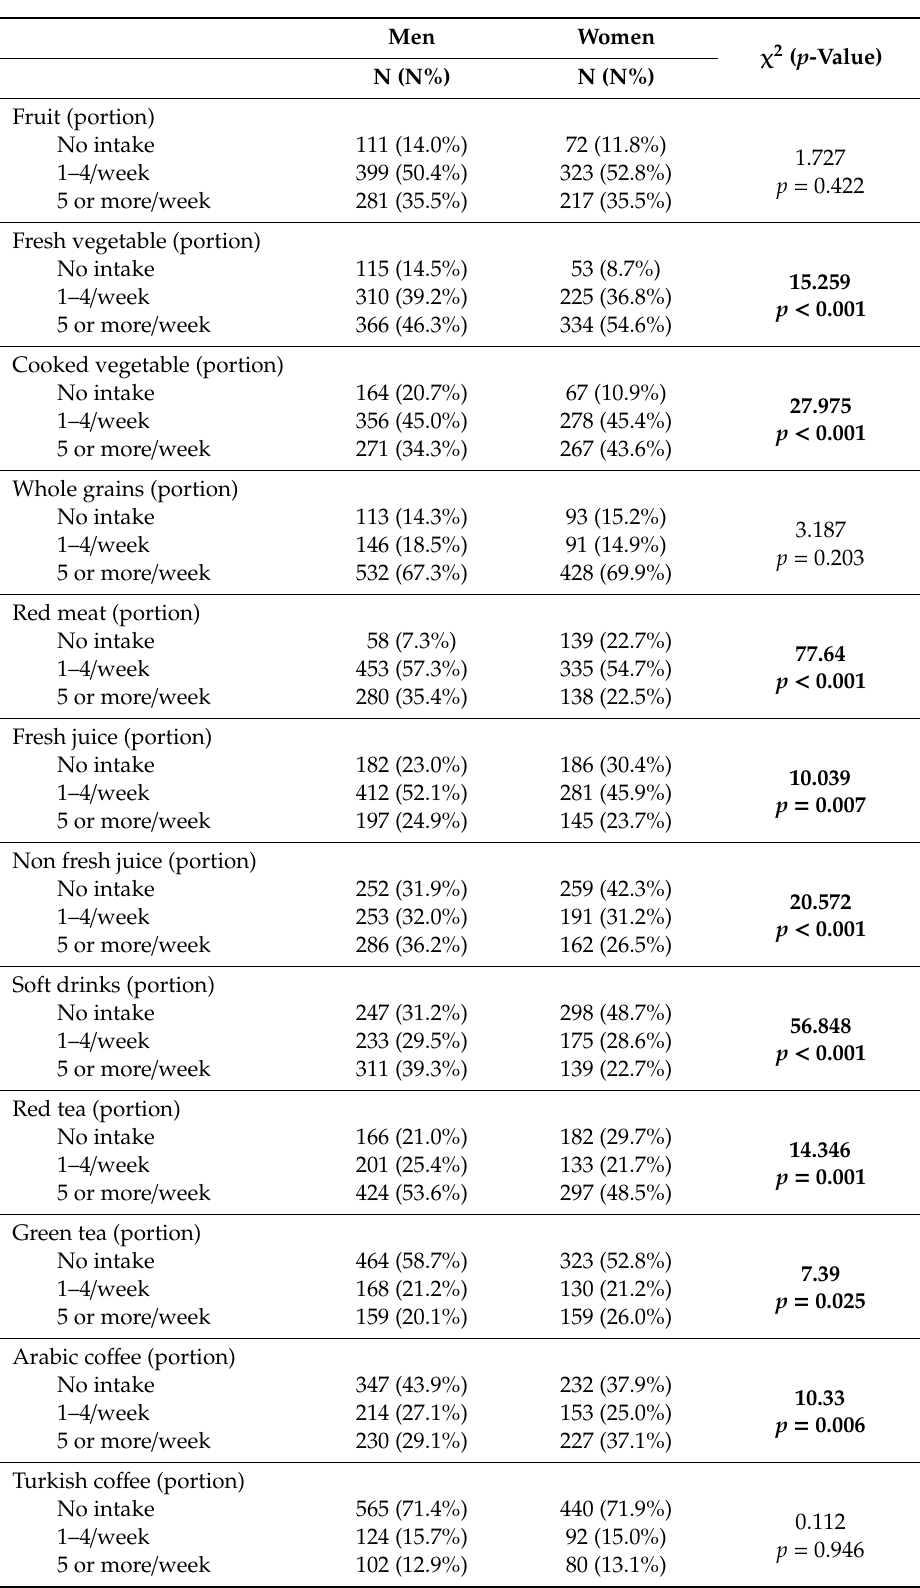
Table 1. Food intake pattern by